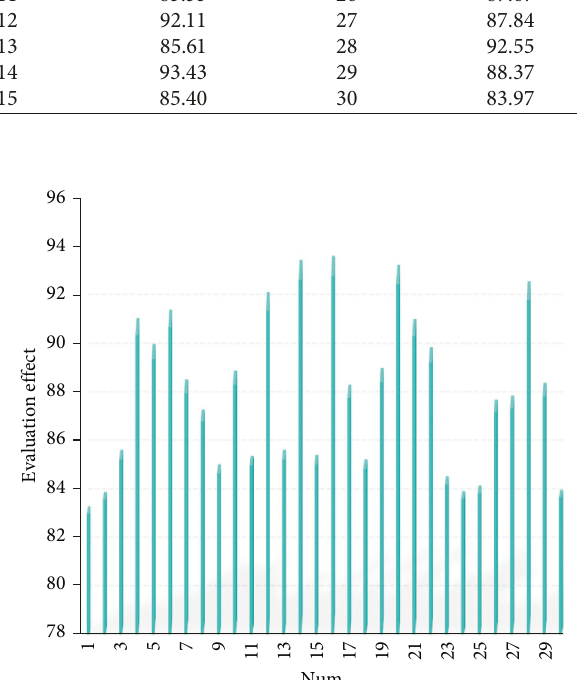
Figure 11: Statistical diagram of the effect of the evaluation system of college English teaching process based on the Rasch